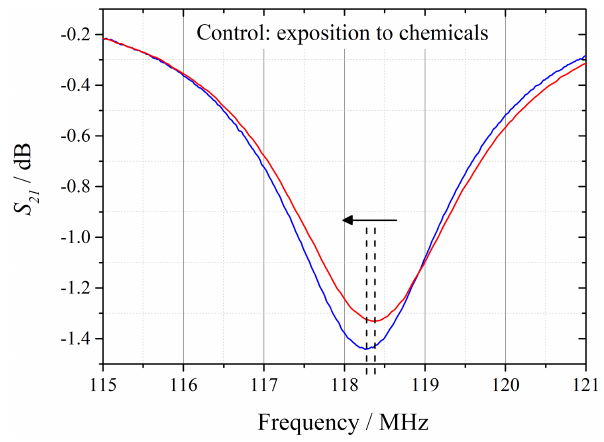
Figure 21. S 21 of control resonator with deionized water as sample before and after exposure to immobilization chemicals.